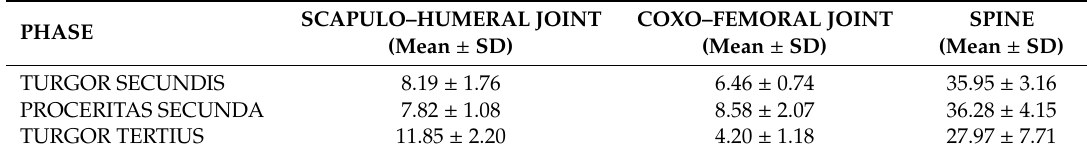
Table 2. Percentage of improvement in flexibility in the di ff erent phases expressed as mean fold change ± SD.